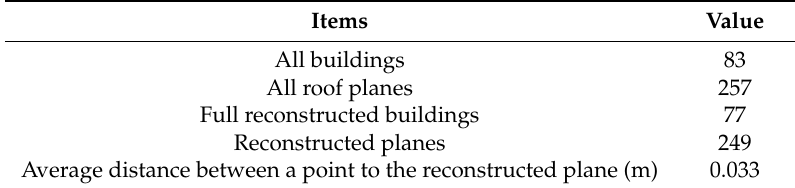
Table 3. Quantitative evaluation results of 3D reconstruction with the Guangdong datasets.